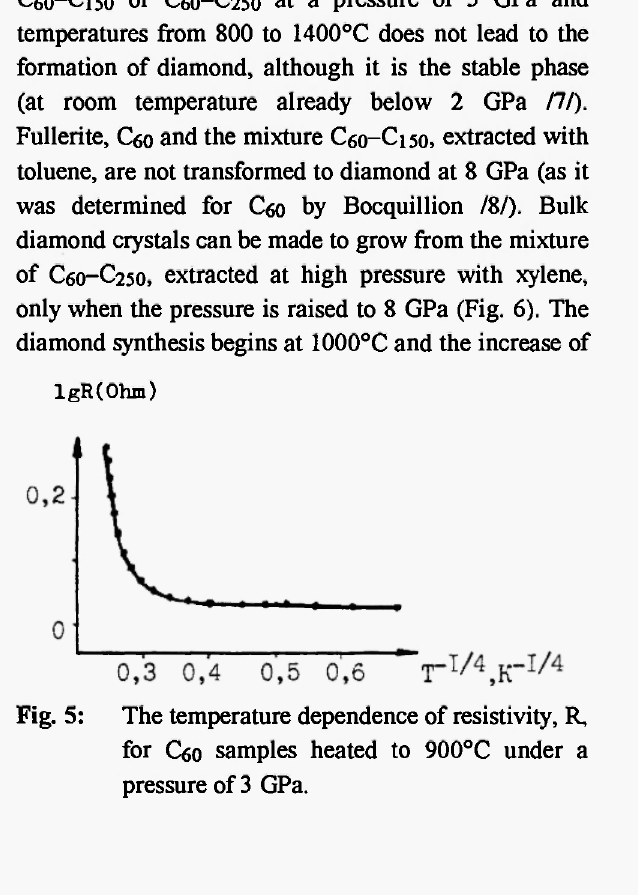
Fig. 6: The variation of the X-ray diffraction profiles with increasing pressure. As the pressure is increased from 5 to 8 GPa, the new diffraction lines indexed as diamond peaks (220) are observed: 1 - 5 GPa, 1630°C, fullerite mixture C60-C250 1650°C, fullerite mixture C60-C250 3 - synthetic diamond produced